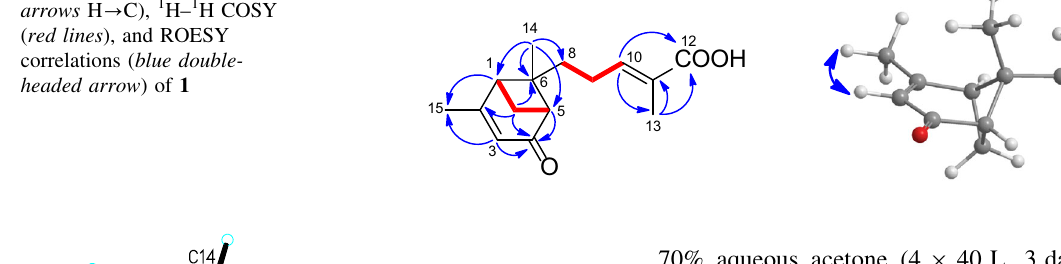
Fig. 2 Key HMBC ( blue arrows H ? C), 1 H– 1 H COSY ( red lines ), and ROESY correlations ( blue double- headed arrow ) of 1